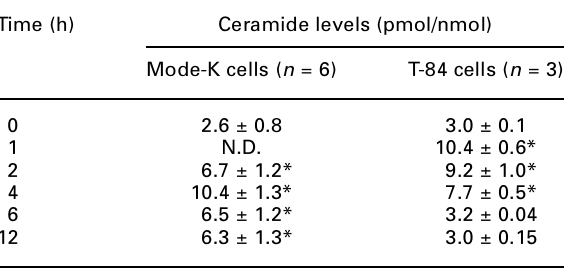
Table 1. Effect of interleukin-1 (IL-1) on ceramide production in intestinal epithelial cells (IEC) a Time (h) Ceramide levels (pmol/nmol) Mode-K cells ( n =